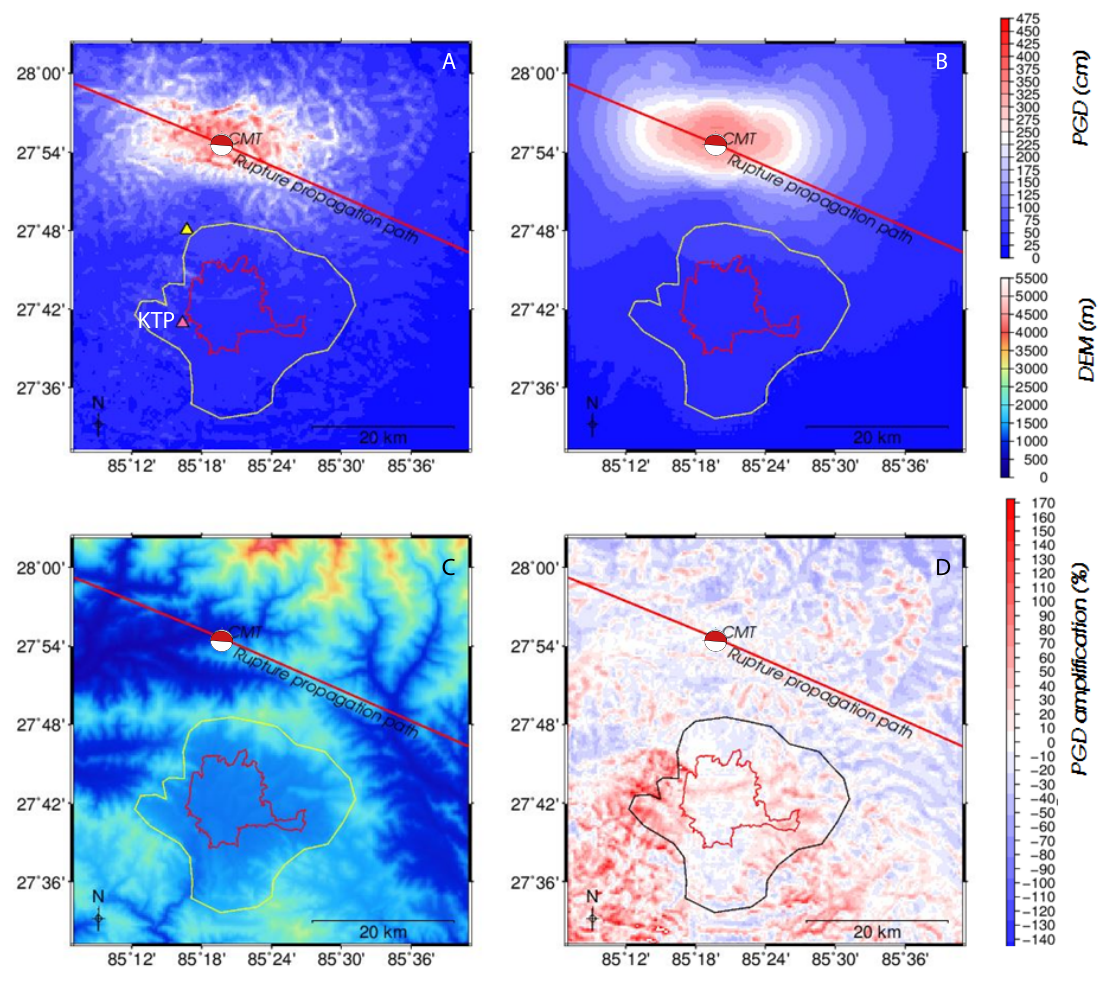
Figure 3. Surface topography and peak ground displacement (PGD) model for the 25 April 2015 Mw 7.8 Nepal Earthquake. ( A ) absolute PGD for a model with surface topography. The recorded data at Kiritipur municipality office accelerometer station (KTP), located on bedrock, is compared with the synthetic seismogram. ( B ) absolute PGD for a model without realistic surface topography. ( C ) Shuttle Radar Topography Mission (SRTM) digital elevation model of the study area; ( D ) PGD amplification map (in %). The rupture propagation path (red line) indicates the path of dominant release of seismic energy.